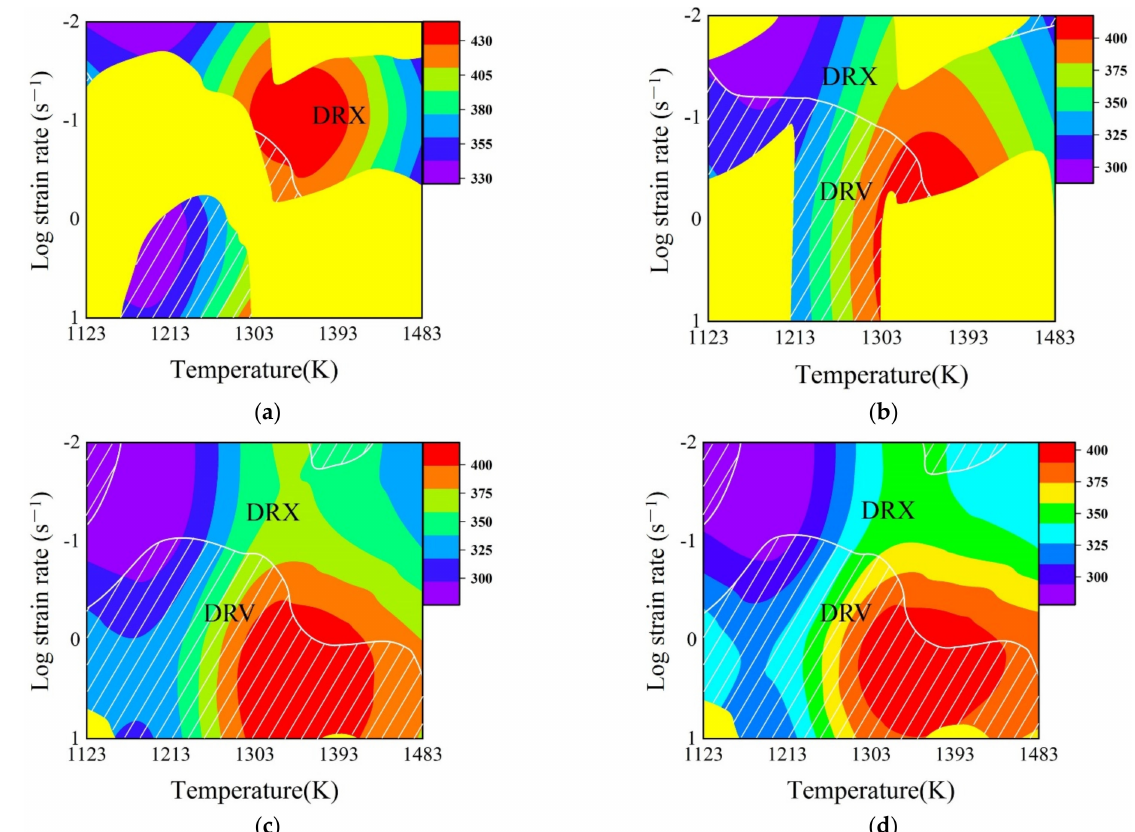
Figure 18. Enhanced deformation mechanism map of SAE 5137H steel under different true strains of